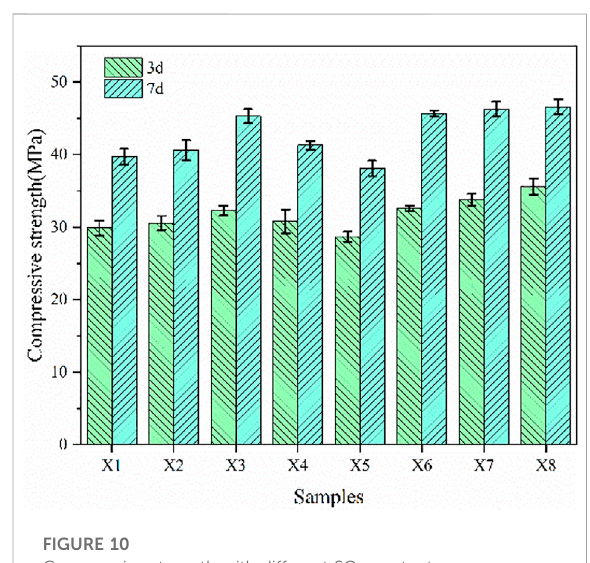
FIGURE 10 Compressive strength with different SO 3 content.